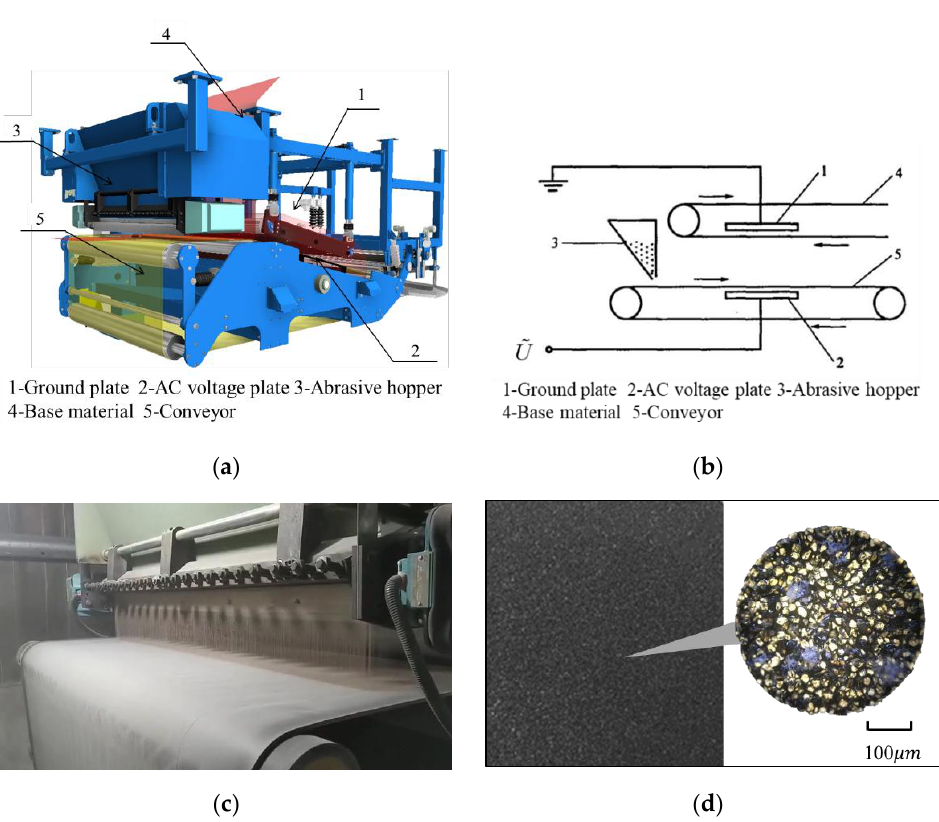
Figure 1. Industrial electrostatic abrasive planting: ( a ) abrasive planting equipment; ( b ) abrasive planting schematic diagram; ( c ) manufacturing site; ( d ) abrasive paper and its microstructure.